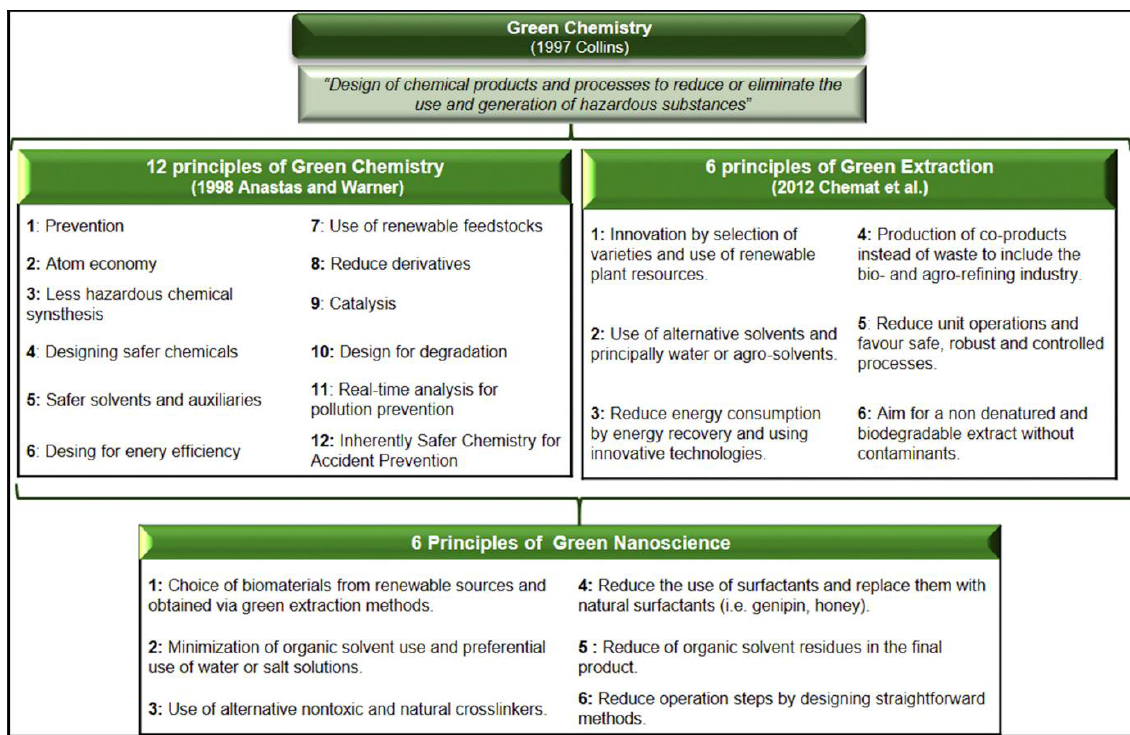
Figure 10. Definitions and principles of Green Chemistry, Green Extraction and Green Nanoscience. Reproduced with permission of [115].